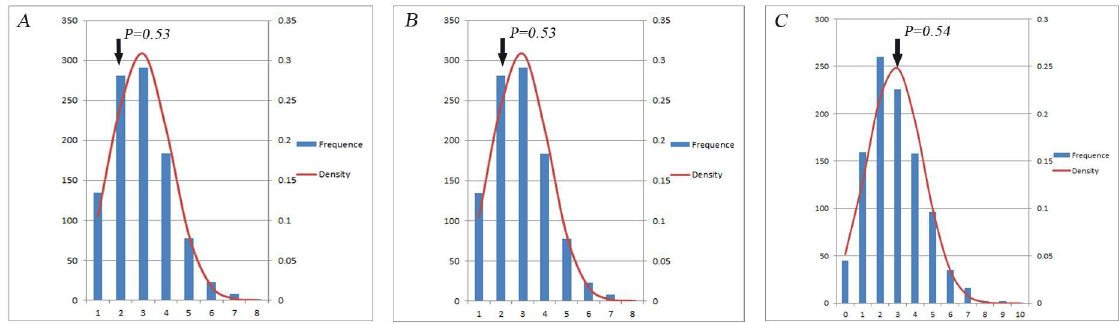
Fig 2. Distribution of permuted number of patients with the candidate CGCP in every 1000 cases. The arrow shows the observednumber of individualswith the toppest candidateCGCP for three (A), four (B) and five (C) SNPs in the